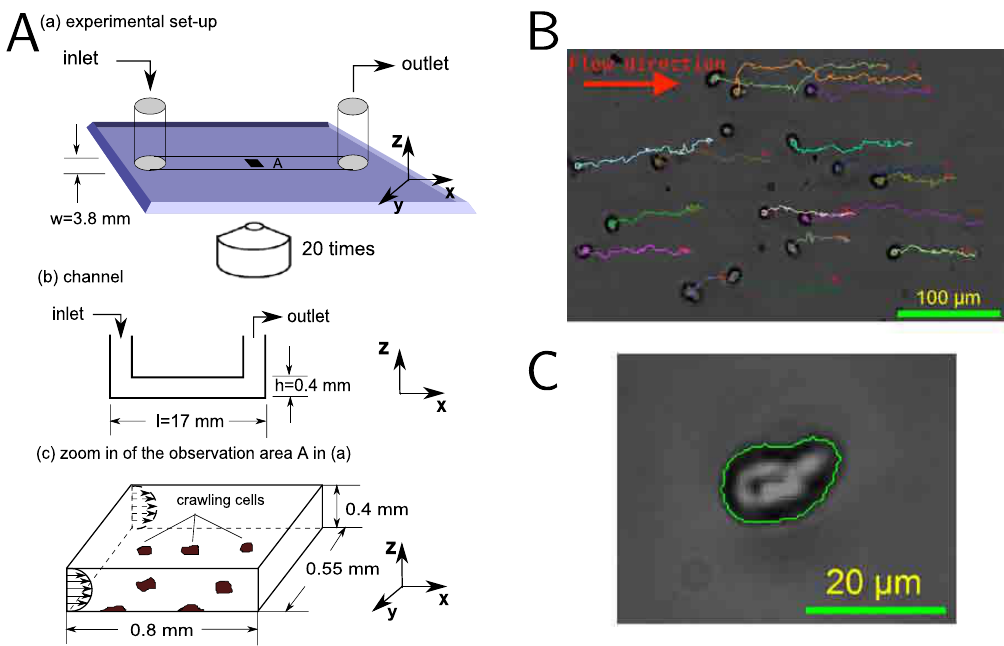
Figure 4. Cell motility device for investigating the effects of shearotactic signals on cell migration. (A) Schematic of the microfluidic device. The external flow circuit comprising the syringe pump—temporally controlling the shearotactic signal—is not represented but is connected to the inlet and outlet of the microfluidic channel. (B) Multiply seeded vegetative unpolarized Dd cells in their initial position with their respective single-cell centroid trajectories superimposed; the flow is towards the right with a shear stress of 0.18 Pa and a soluble calcium concentration of 3 mM. (C) Close-up of a single vegetative Dd cell with its detected boundary used to determine the cell’s centroid. For each shear stress levels and calcium concentrations considered, a large number of cells are analyzed (Fig. S1), providing statistically relevant data.